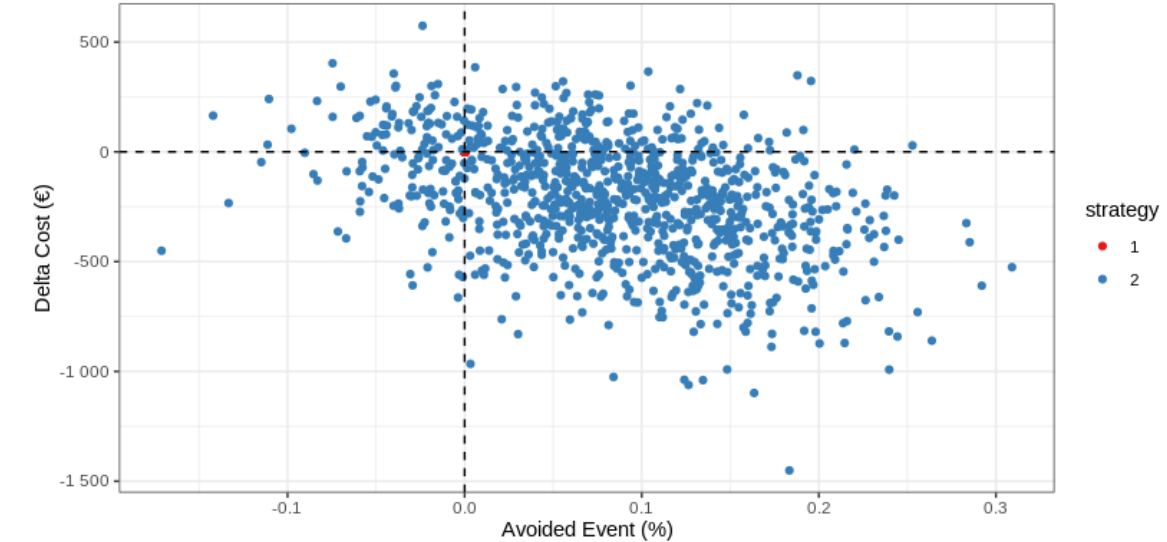
Figure 3. Scatter plot of incremental cost and effectiveness of CT (strategy 2) compared to US (strat- egy 1) as the reference. (strategy 1) as the reference.